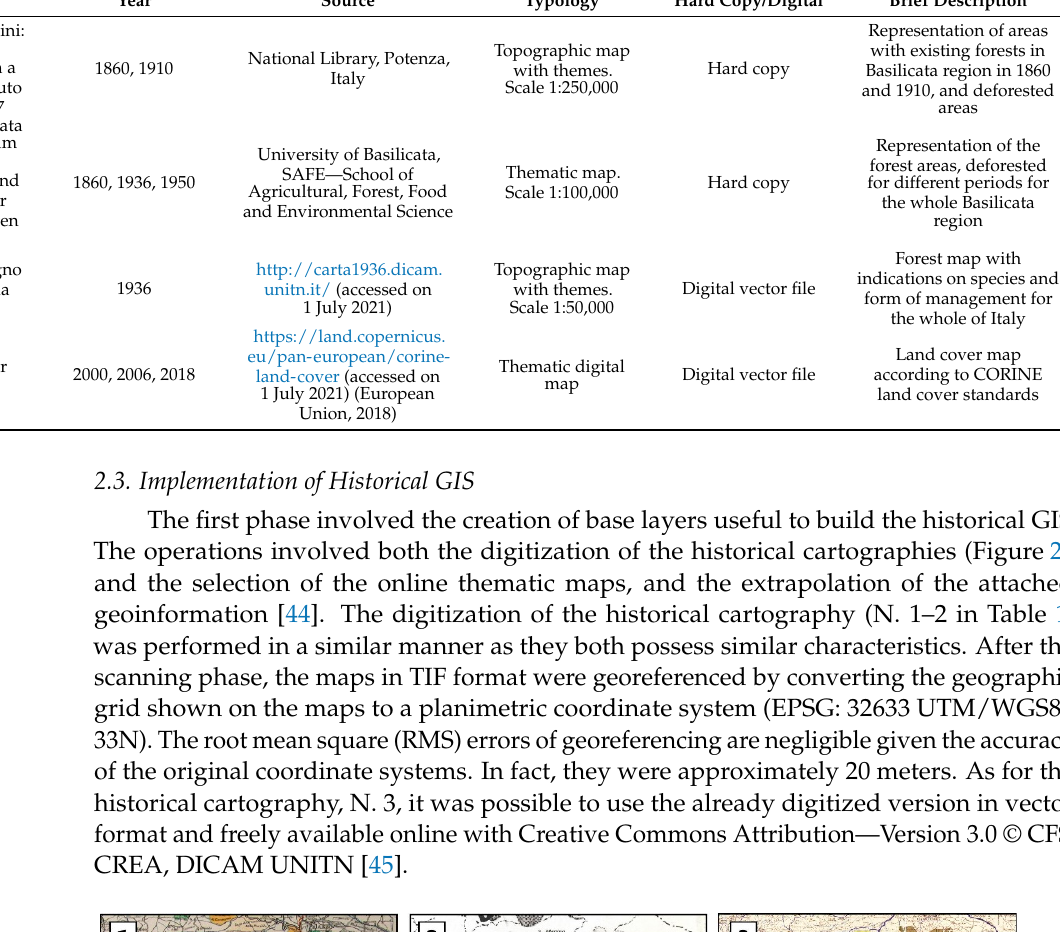
Table 2. Main features of the datasets used for the years 2000, 2006 and 2018, as reported in the 200 metadata and technical documents [46].